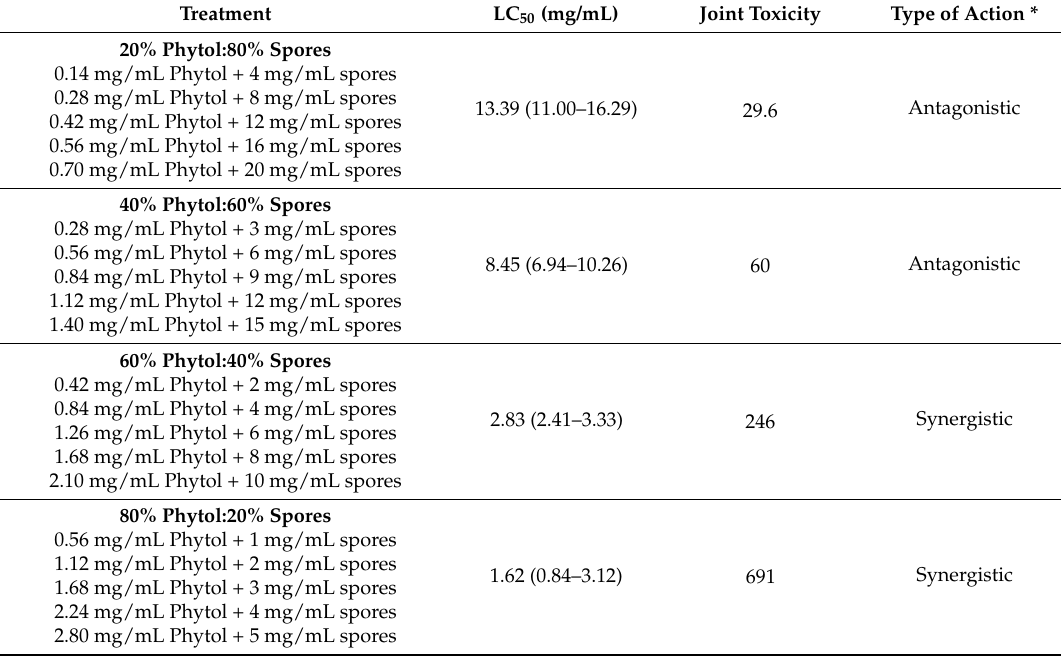
Table 2. Joint toxicity evaluation of phytol and Beauveria bassiana isolate B6903 against Oligonychus afrasiaticus